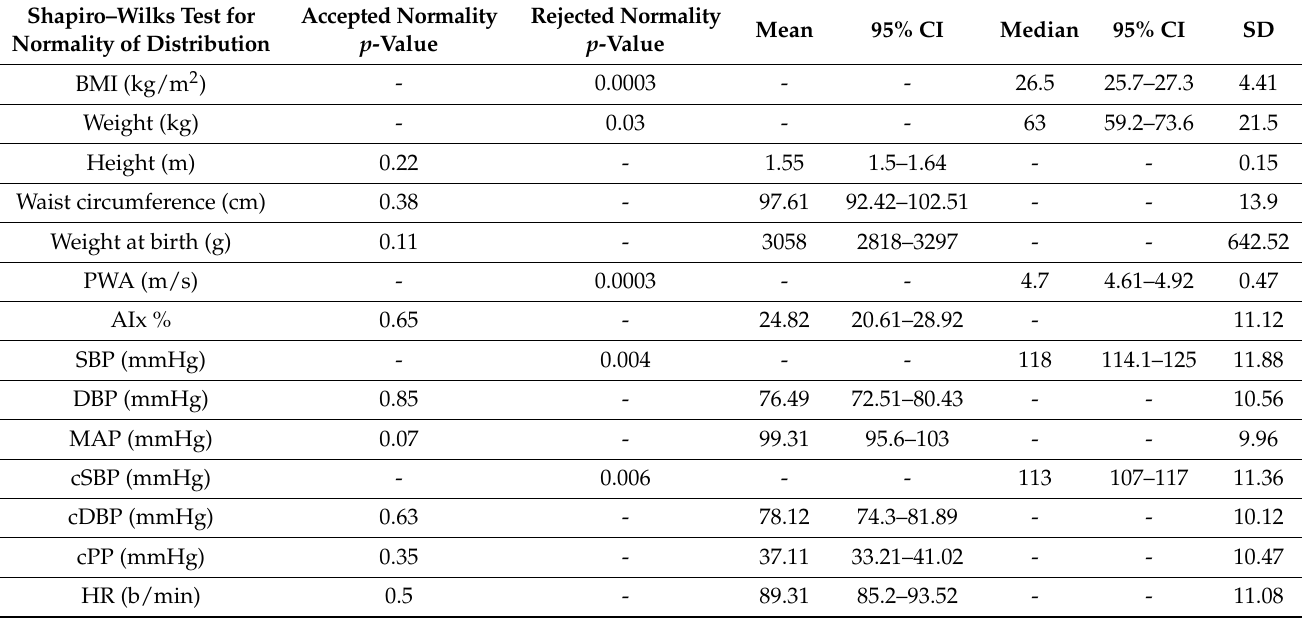
Table 1. Normality and descriptive analysis of variables in the obese group ( n = 30).